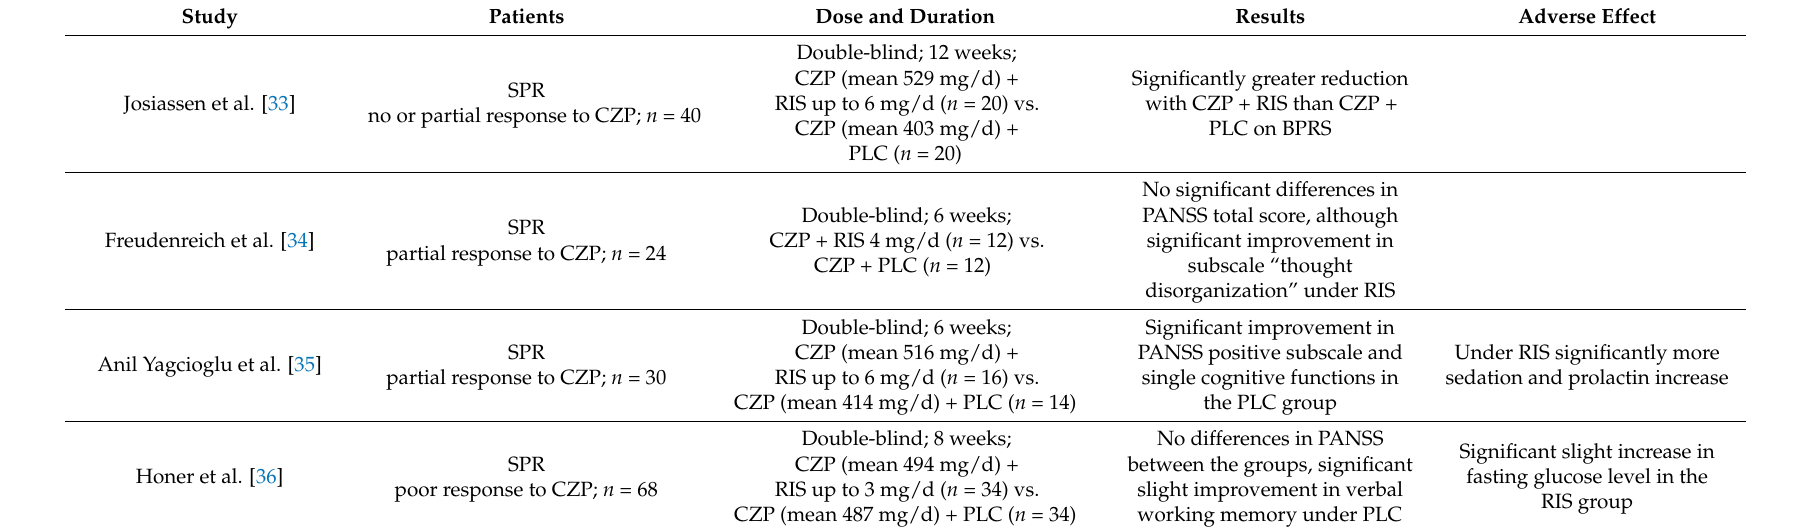
Table 1. Summary of randomized controlled studies of clozapine combined with